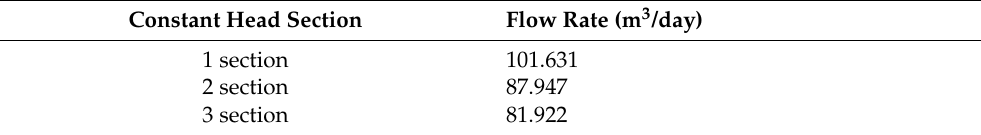
Table 6. Flow rate for the western margin of the Dravsko polje aquifer. Constant Head Section